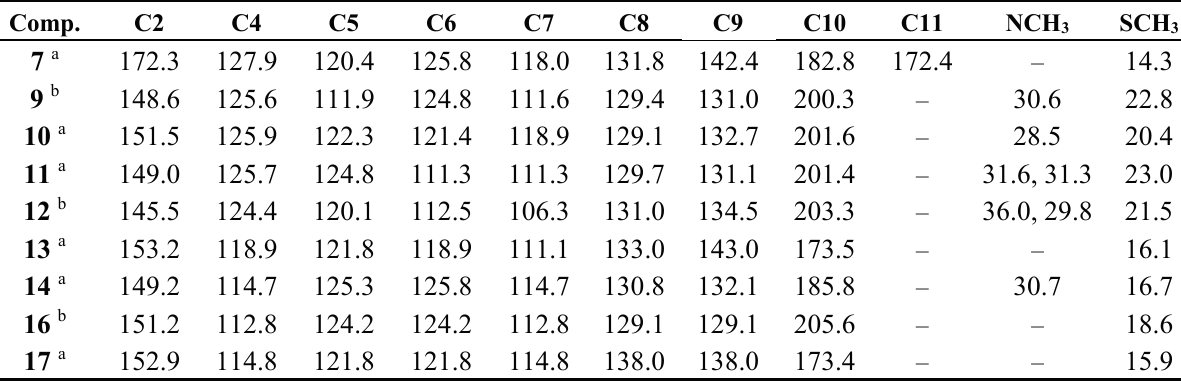
Table 2. 13 C-NMR chemical shifts of compounds 7 , 9 – 14 , 16 and 17 .